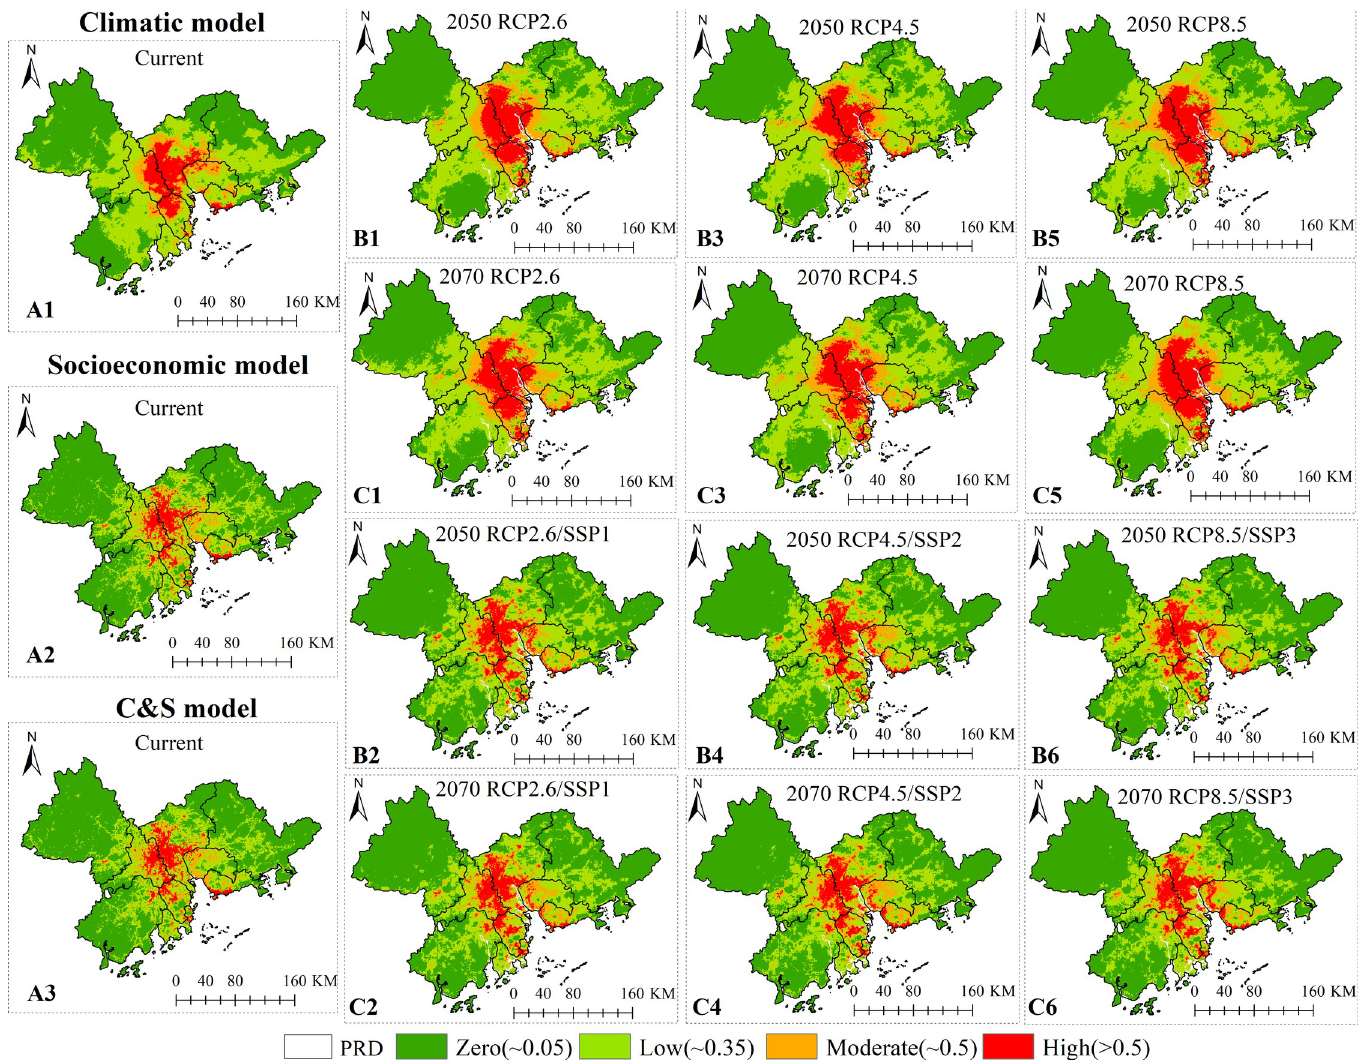
Fig 4. Predictive maps of current and future DF risk distribution in the different variables model. A1, B1, B3, B5, C1, C3, and C5 are the DF risk spatial distribution predicted by the climatic model. A3, B2, B4, B6, C2, C4, and C6 are the DF risk spatial distribution predicted by the C&S model. A2 is the DF risk spatial distribution predicted by the socioeconomic model. Please note that the socioeconomic model in the future is not considered here because the spread of mosquito vectors cannot be separated from climate change, and the simulation results of the socioeconomic model is the worst based on previous results. https://www.resdc.cn/data.aspx?DATAID=